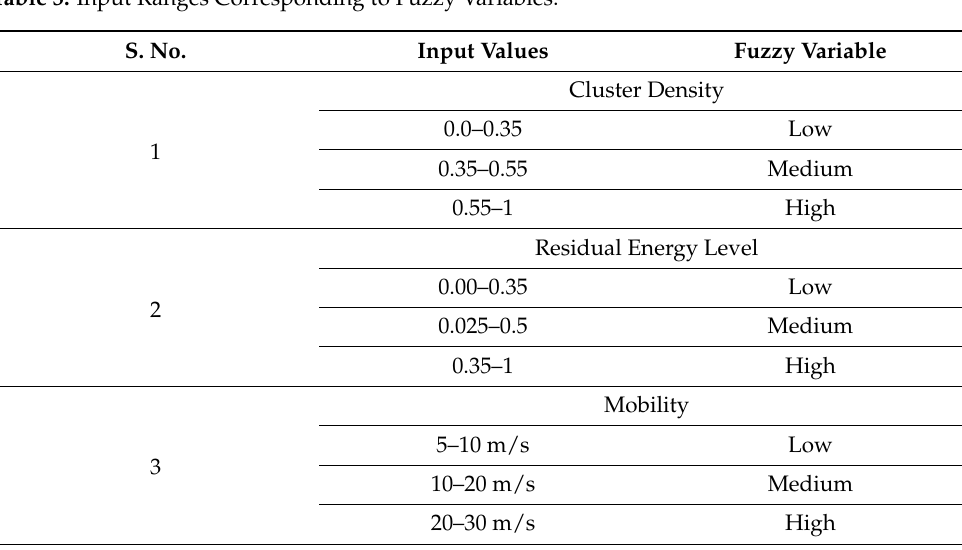
Table 3. Input Ranges Corresponding to Fuzzy Variables.